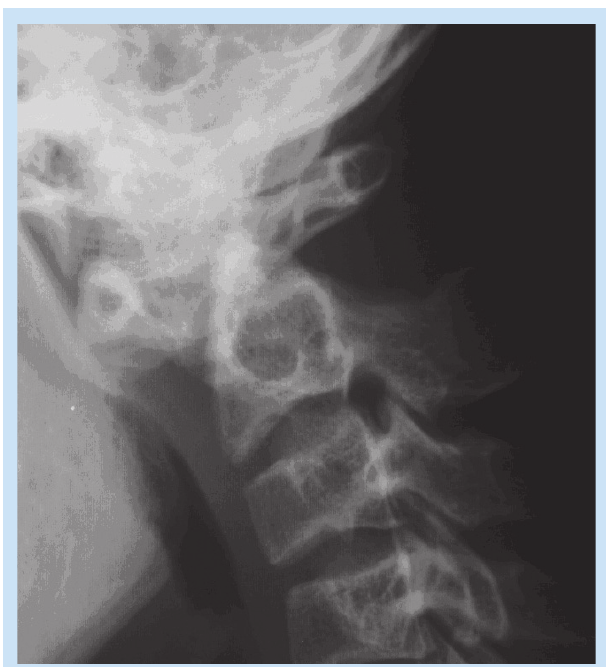
Fig. 3. Flexion view demonstrating a decrease in spinal canal diameter with flexion while the ADI increases in dimensions.